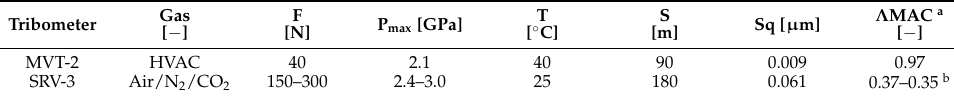
Table 1. Conditions of tribology